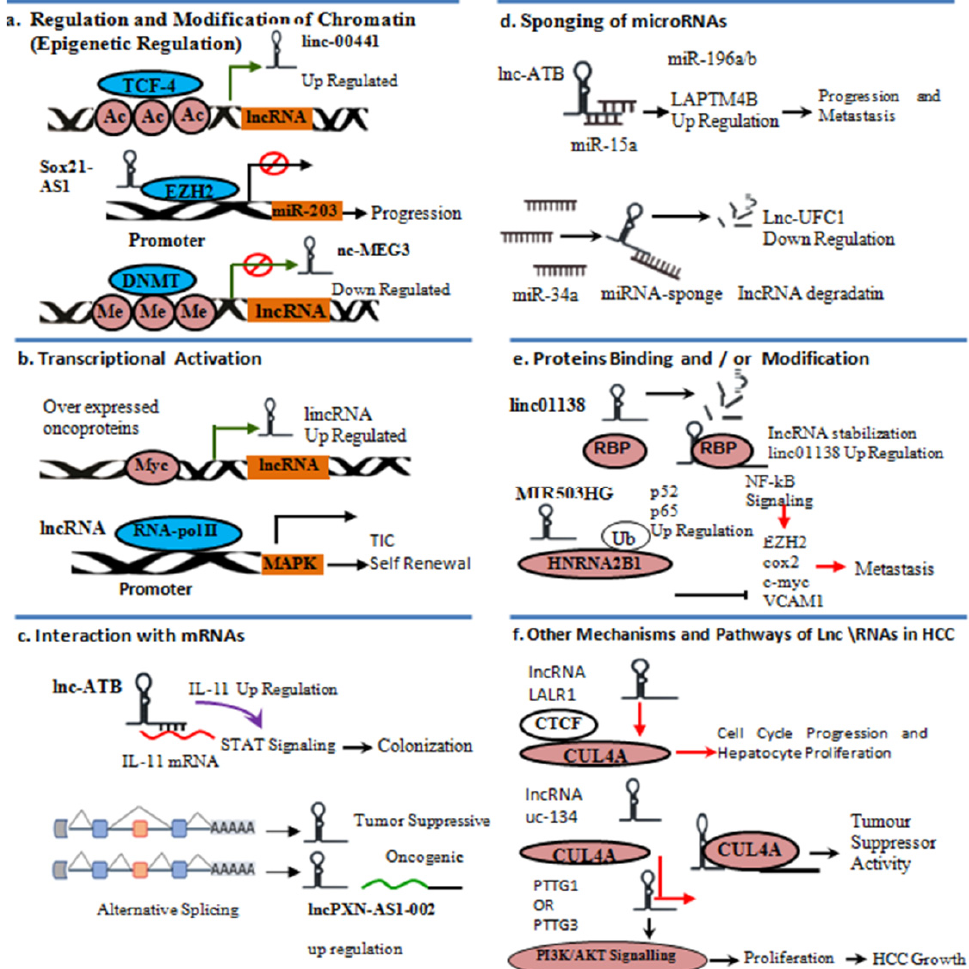
Figure 4. The roles of lncRNAs in HCC. ( a ) Regulation and modification of chromatin. ( b ) Transcriptional activation. ( c ) Interaction with mRNAs. ( d ) Sponging of microRNAs. ( e ) Protein binding and modification. ( f ) Other mechanisms and pathways of lncRNAs.